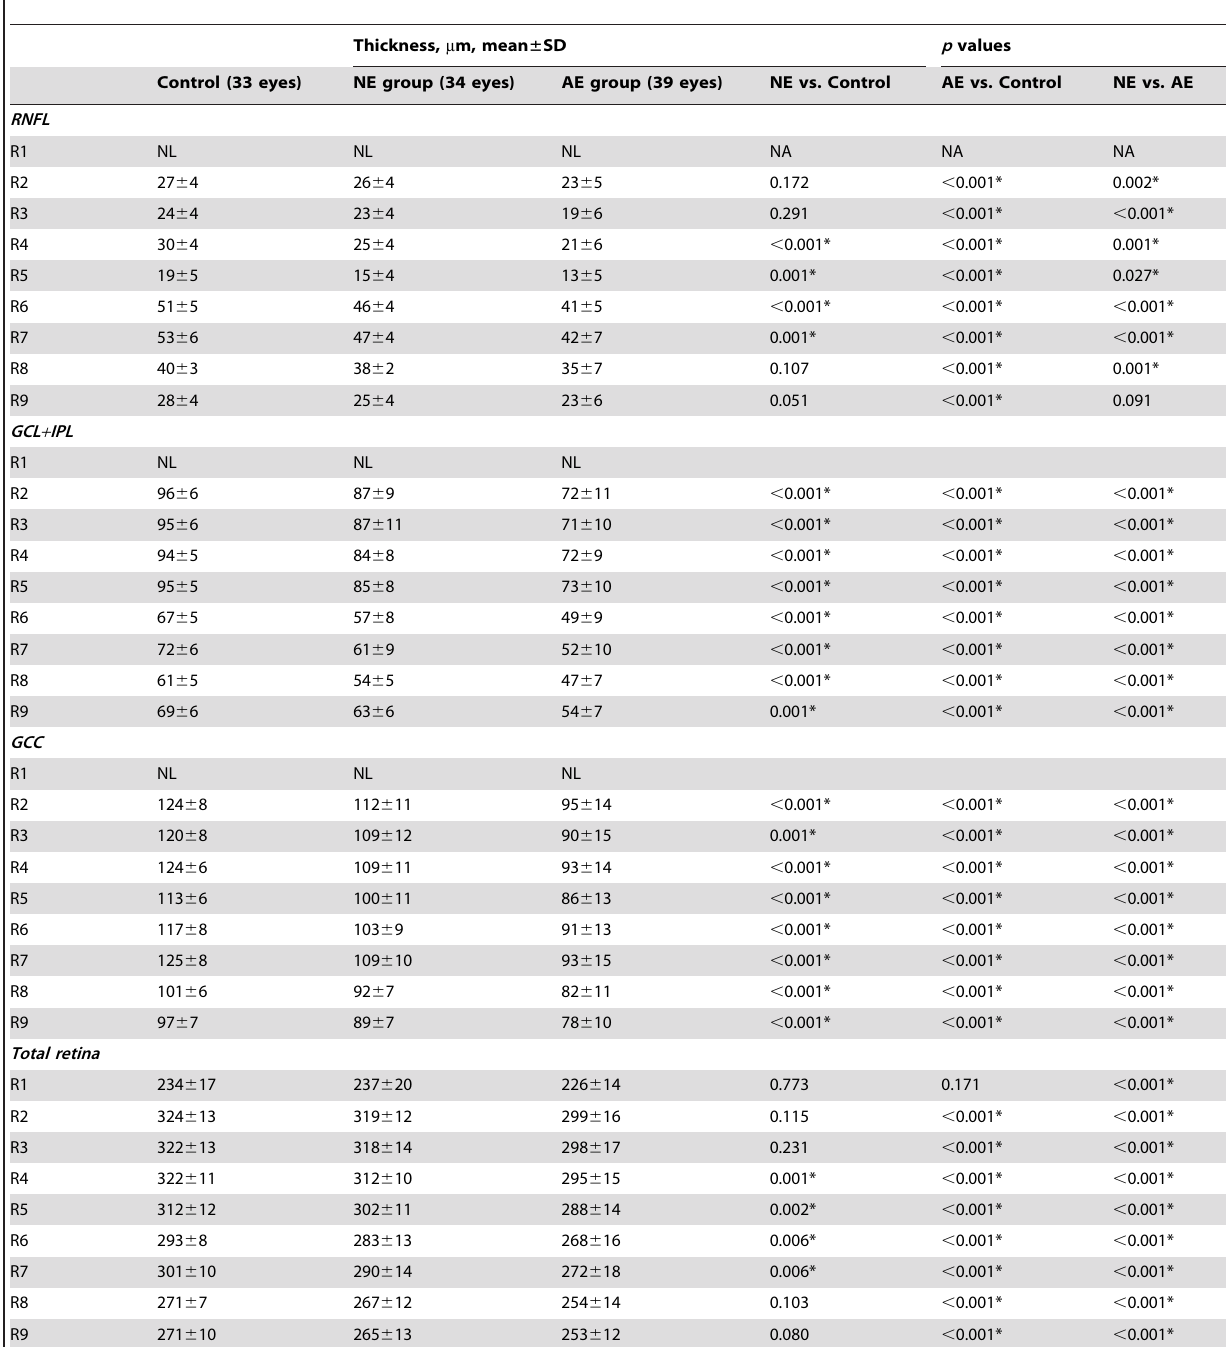
Table 3. Regional differences in the thickness of the intraretinal layers in the groups which showed statistically significant